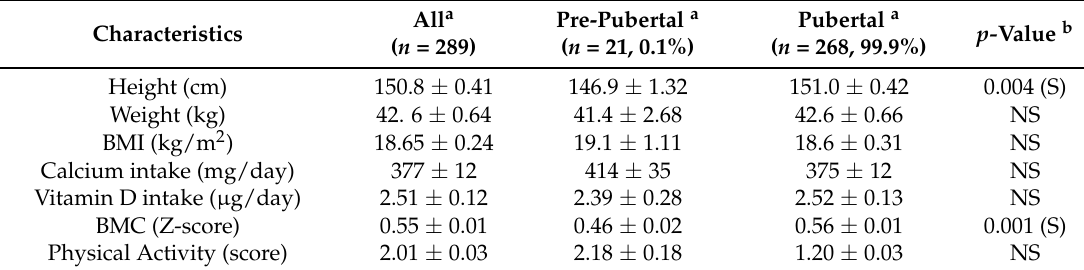
Table 2. Characteristics according to puberty level ( n =